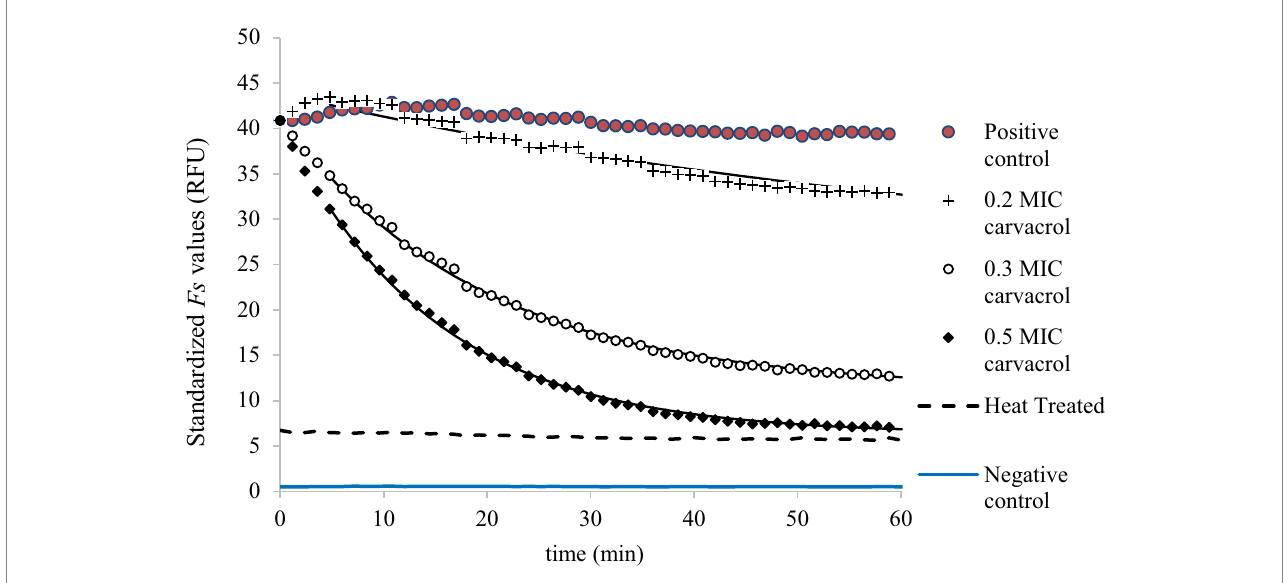
FIGURE 5 Dissipation model fitted to the standardized Fs curves, demonstrating the membrane integrity of bacteria at 0.2, 0.3, and 0.5 MIC carvacrol treatments in exponential phase culture of E. coli ATCC 11229. As a negative control, Fs values were also measured in uninoculated suspension (PBS) and membrane integrity of heat-treated culture (80 ° C, 15 min) is also shown. Non-treated culture was the positive